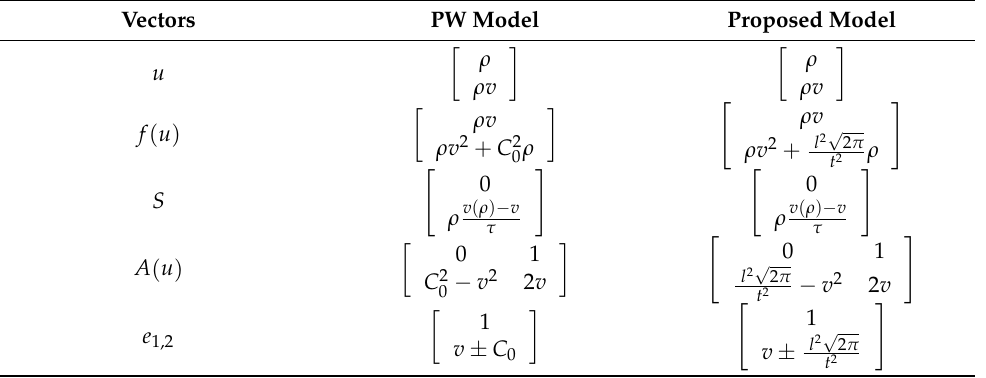
Table 2. Vectors of the PW and proposed